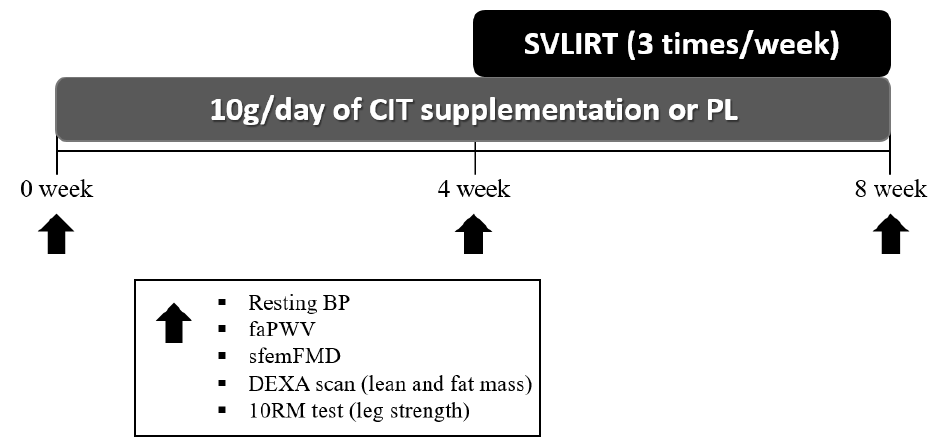
Figure 2. Experimental protocol. CIT, L-citrulline; PL, placebo; SVLIRT, slow-velocity low-intensity resistance training; BP, blood pressure; faPWV, femoral-ankle pulse wave velocity; sfemFMD, superficial femoral artery flow-mediated dilation; DEXA, whole-body dual-energy X-ray absorptiometry; RM, repetition maximum.